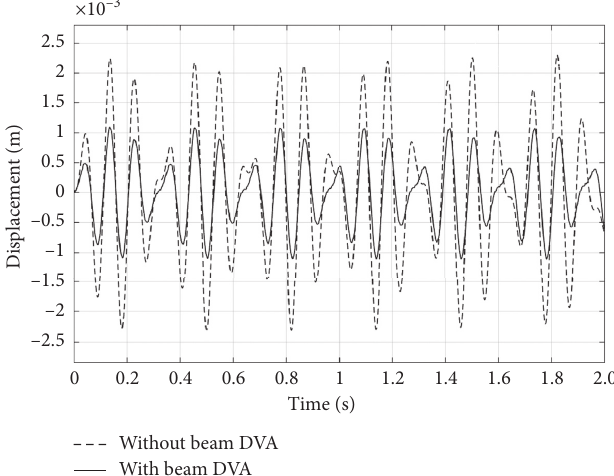
Figure 9: Numerical results of the 1-inch pipeline structure under the excitation frequency of 12.5Hz.